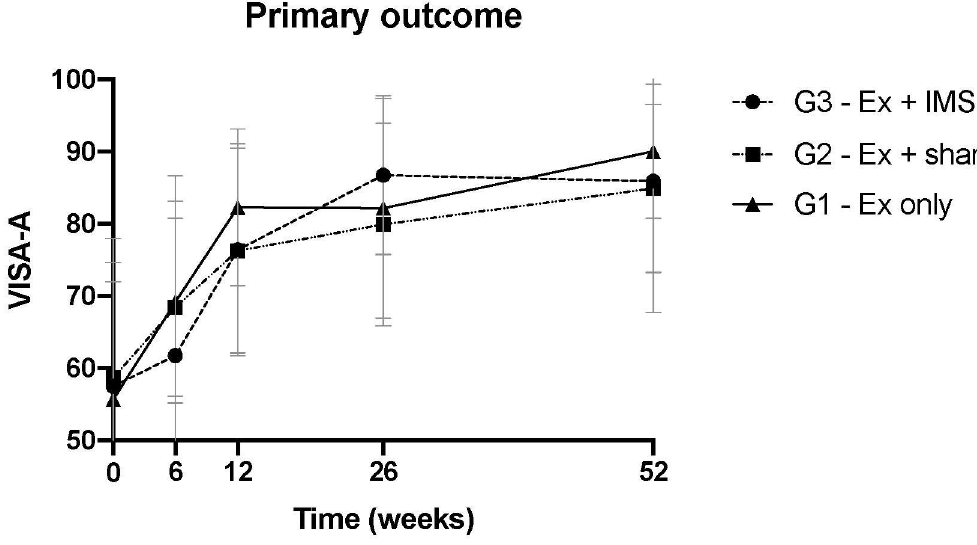
Fig 2. Change in symptom severity over time. Mean and standard deviation are shown. VISA-A: Victorian Institute of Sport Assessment–Achilles. Ex–exercise. IMS–intramuscular stimulation (i.e. dry needling).